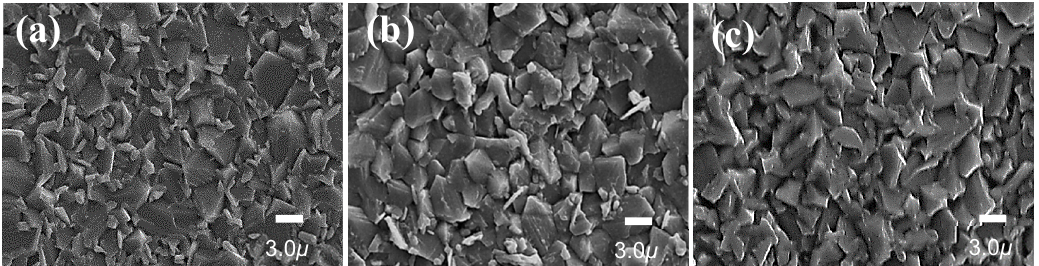
Figure 9. FE-SEM images of the Ni 1 − x Zn x Fe 2 O 4 (x = 0.5, 0.6, 0.7) samples sintered at 1250 ° C : ( a ) x = 0.5, ( b ) x = 0.6, and ( c ) x = 0.7.